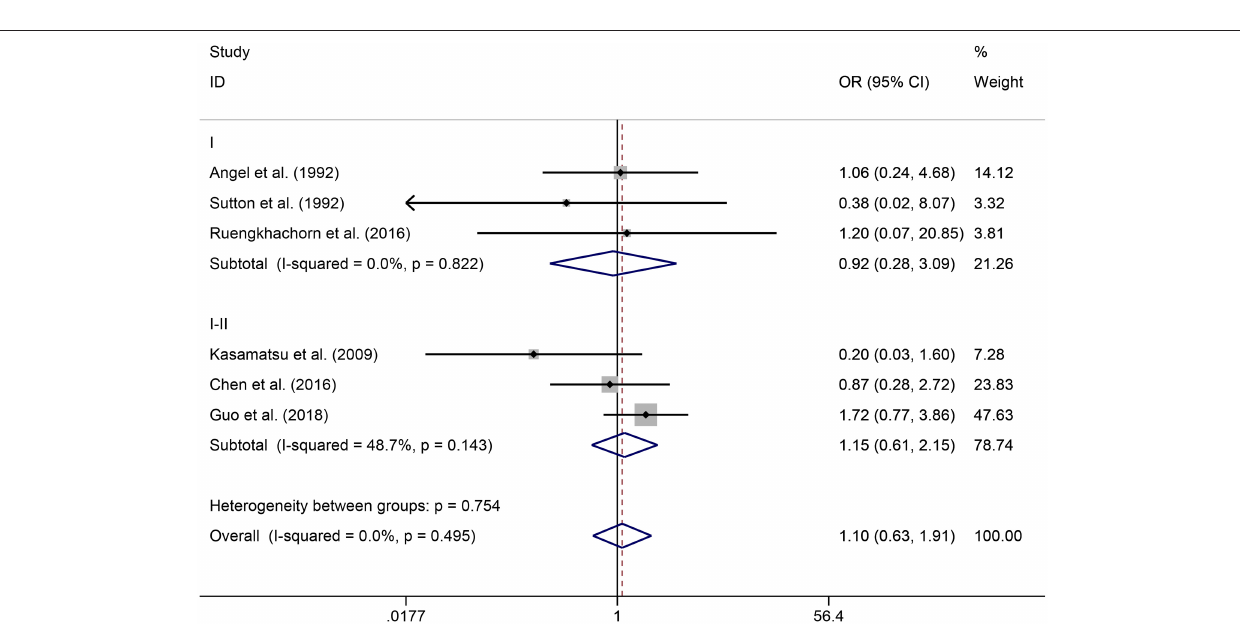
FIGURE 5 | Subgroup analysis of PFS for ovarian preservation vs. oophorectomy in early stage cervical adenocarcinoma. Weights were from fixed-effects